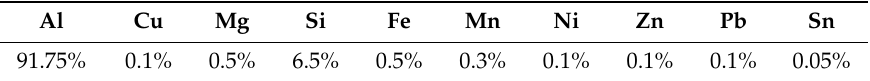
Table 1. Chemical composition of LM 25 aluminum alloy.